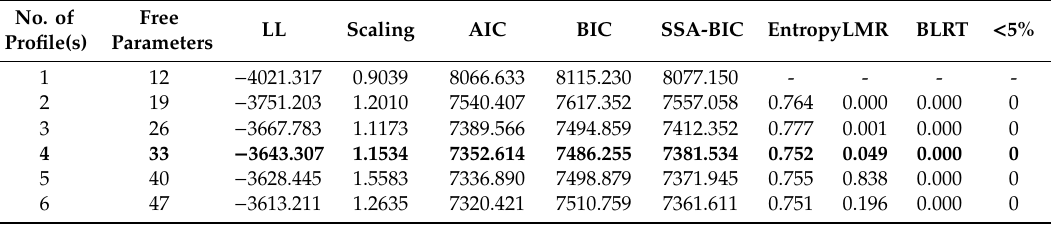
Table 2. Latent profile fit